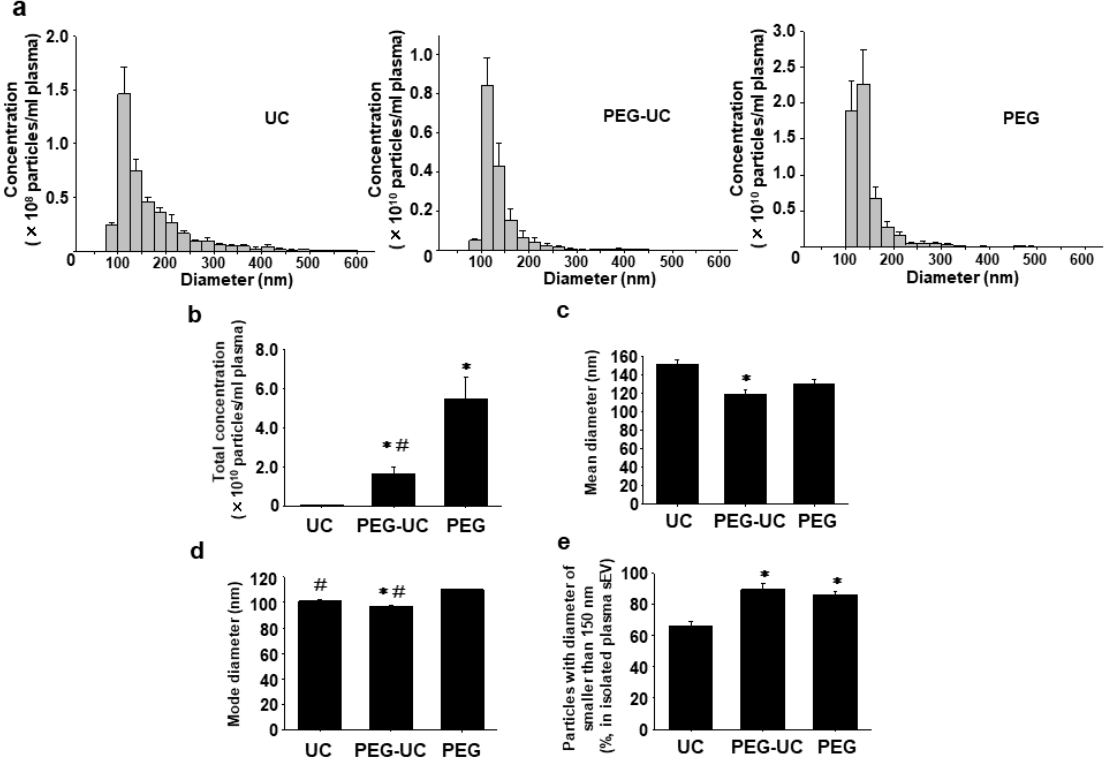
Figure 2. Concentration and size distribution of plasma sEVs isolated by three (UC, PEG-UC, or PEG) methods. sEVs were isolated from the EDTA (1 mg / mL)-anticoagulated plasma in male Wistar rats (7–9-week-old) by the three methods as described in Figure 1. Concentration and size distribution of sEVs were measured by a tunable resistive pulse sensing analyses (TRPS) method using a qNANO instrument. ( a ) Concentration and size distribution of plasma sEVs were shown. The concentration was normalized to the starting volume of plasma (particles / mL). ( b ) Total concentration of plasma sEVs was shown (particles / mL). ( c , d ) Mean and mode (most frequent) diameters of plasma sEVs were shown. ( e ) The percentage of particles with a diameter of smaller than 150 nm in total particles of plasma sEVs was shown. Results were expressed as means ± standard error of the mean (SEM) in bar graphs ( n = 4). * p < 0.05 vs. UC, # p < 0.05 vs. PEG.